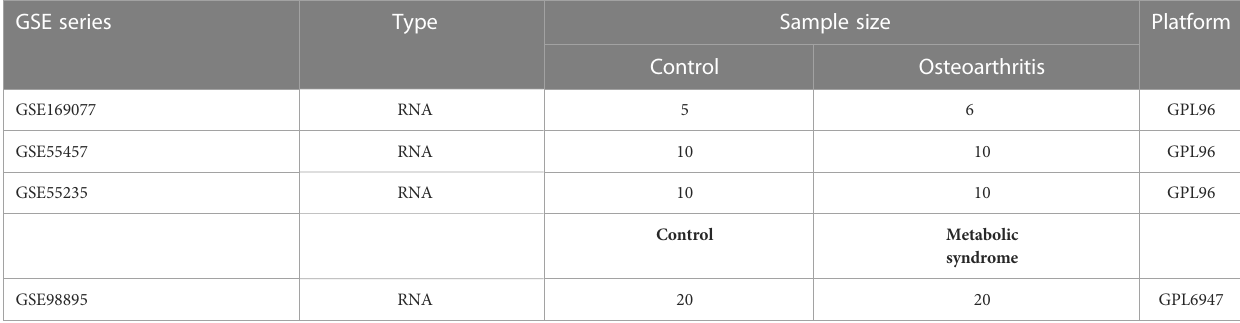
TABLE 1 Basic information of GEO datasets used in the